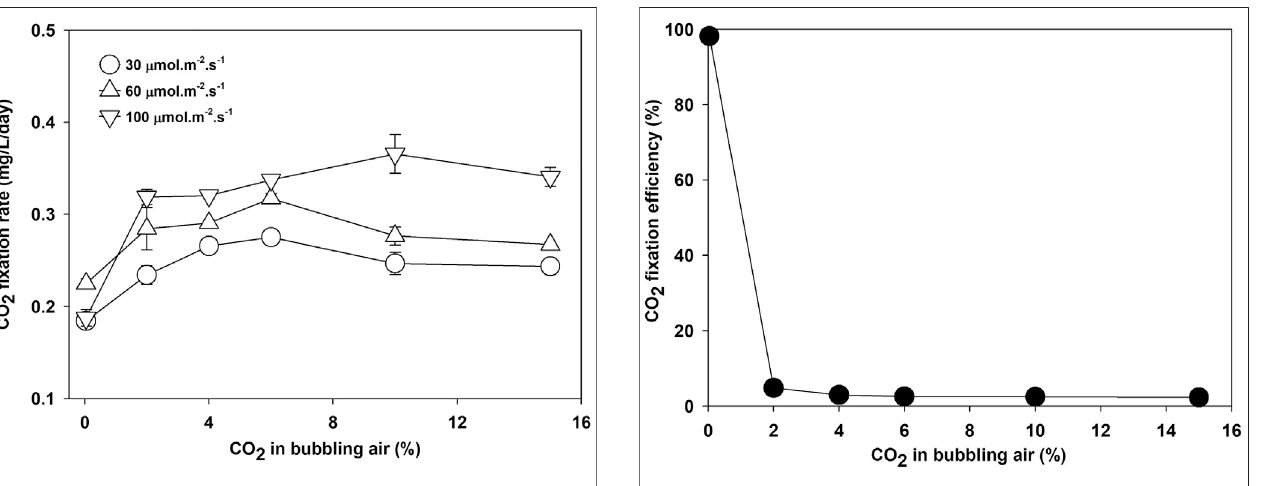
FIGURE 6 | CO 2 fi xing ef fi ciency by microalgae Parachlorella kessleri HY-6 at a different CO 2